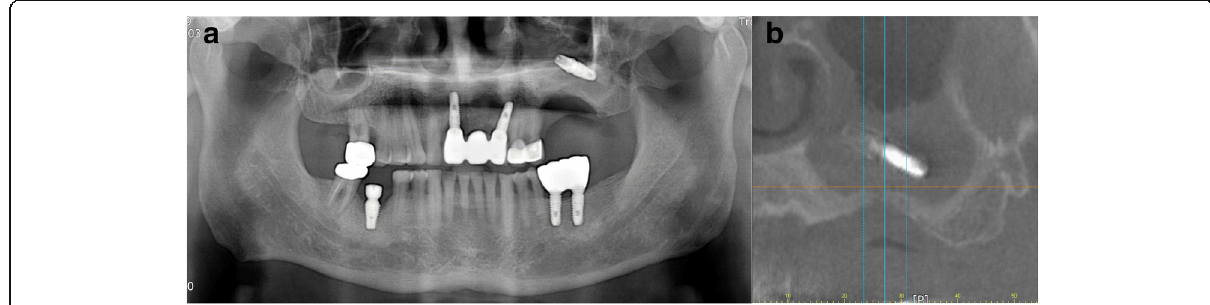
Fig. 1 Preoperative a panoramic view and b CBCT view